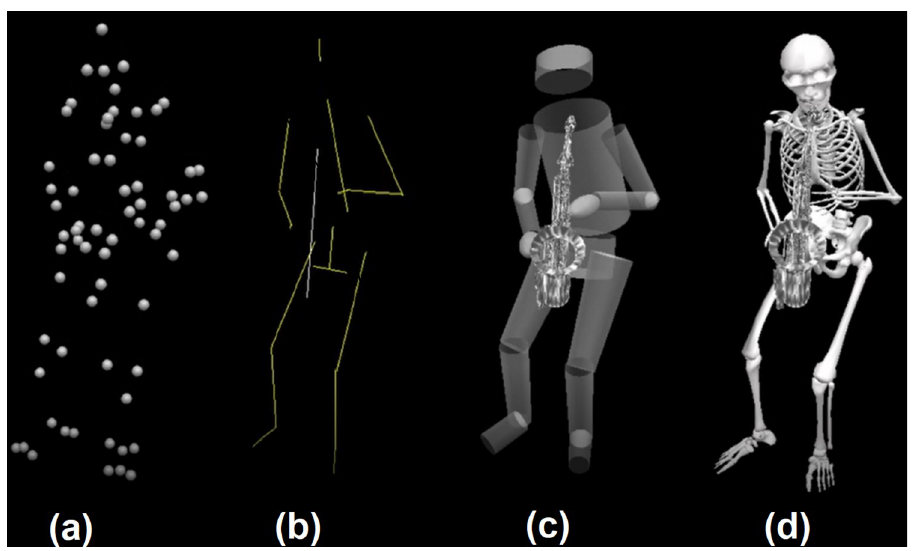
Fig 1. The four types of visual display used in this study. (a) PL: point-light, (b) SF: stick figure, (c) BM: body mass and (d) SK: skeleton.